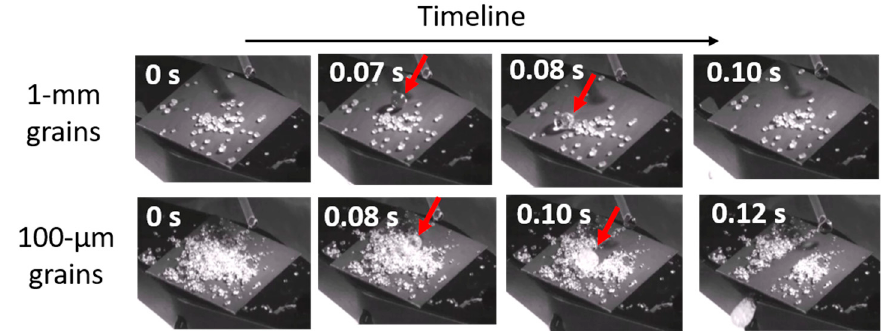
Figure 4. Self-cleaning property of the laser-textured aluminum substrate. Snapshot of the droplet rebounding. Two different grain dimensions have been tested.